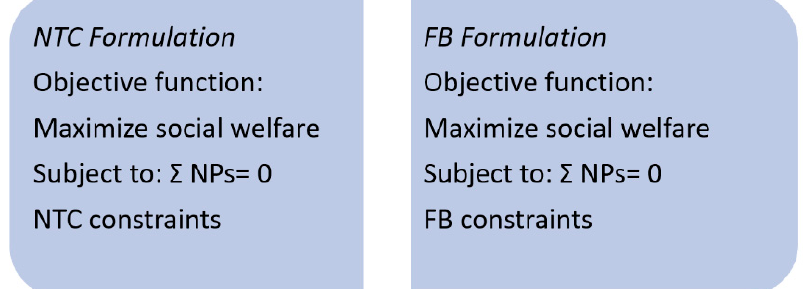
Figure 2. Formulation of the NTC and FB algorithm.